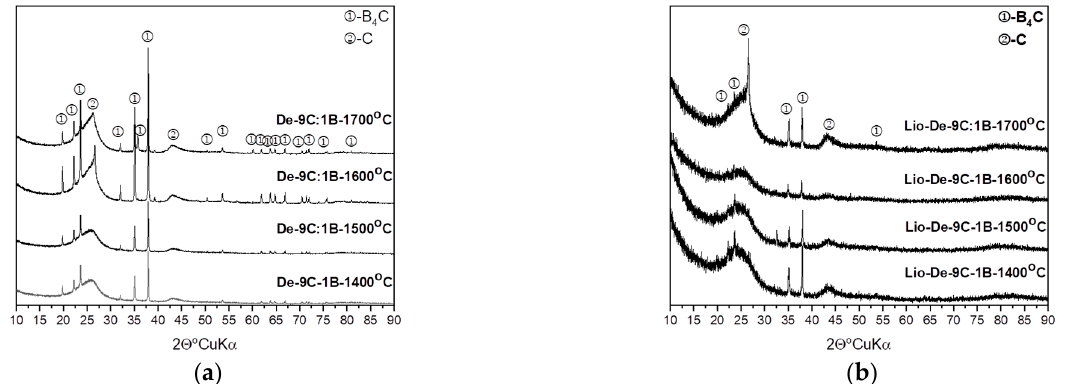
Figure 7. The X-ray patterns of the powders prepared from the mixtures of dextrin: ( a ) recrystallized and ( b ) lyophilized.